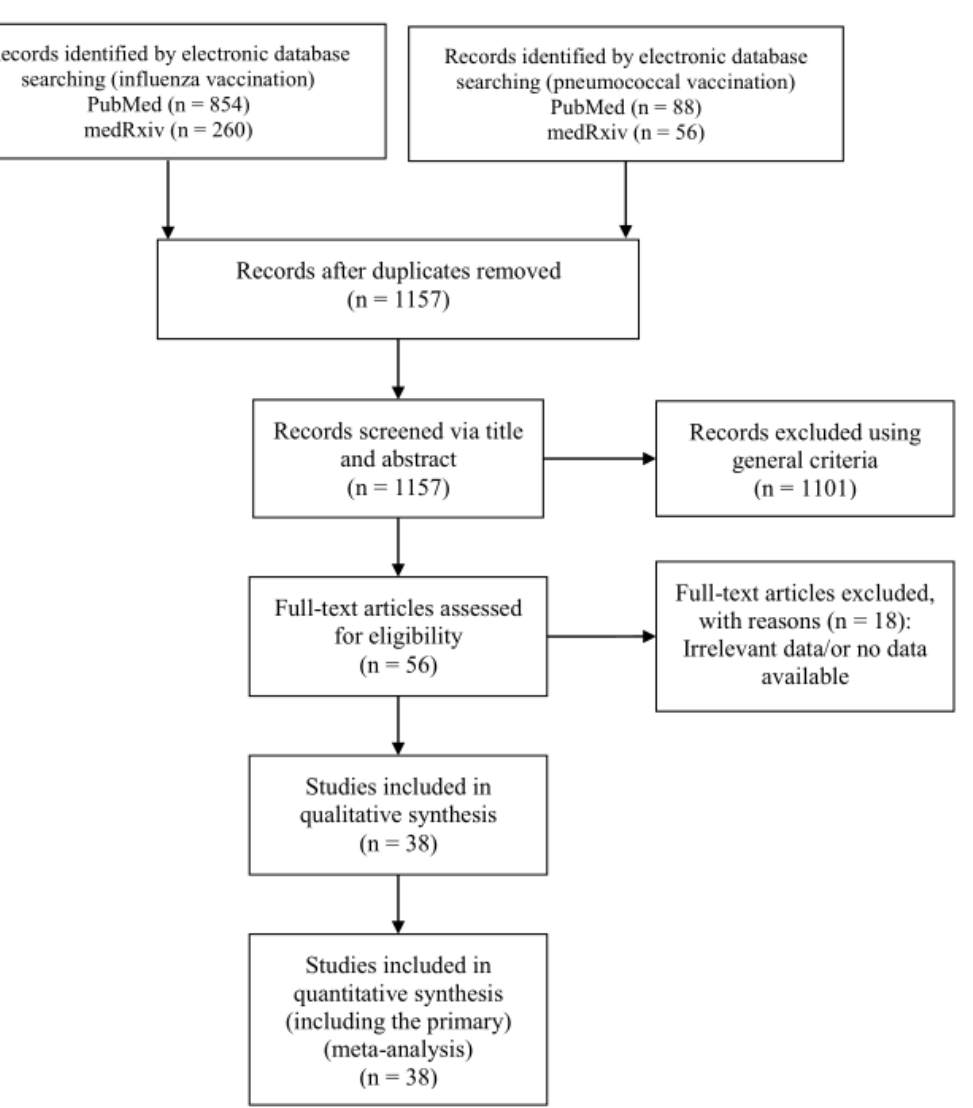
Figure 1. The PRISMA flow diagram for the included studies.